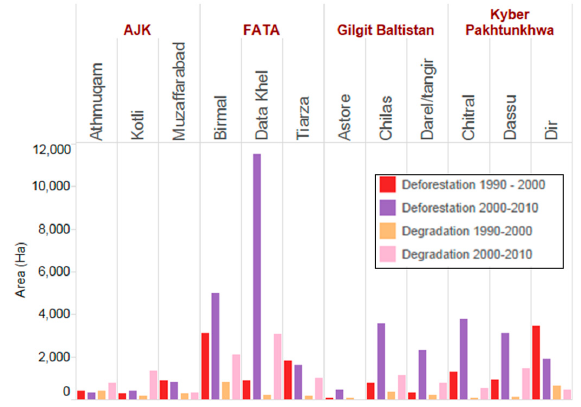
Figure 4. Most deforested sub-districts in terms of administrative unit.